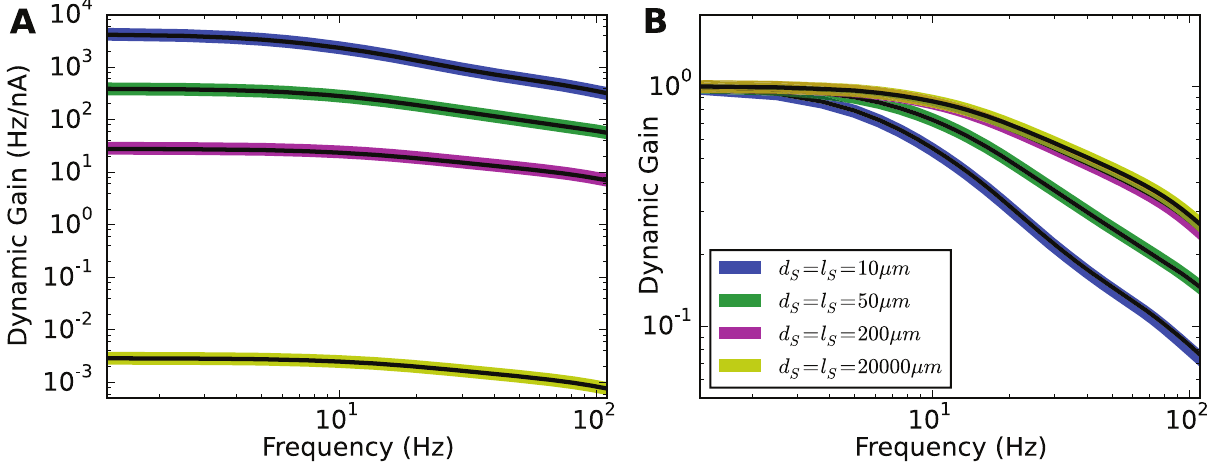
Fig 10. Effect of soma size on dynamic gain. A Unnormalized dynamic gain curves for various soma sizes. Diameters and lengths for all the soma are was fixed to 40 μ m. The correlation time τ was fixed to 5ms. For each soma size, fixing surface area but reducing shown in the legend panel in B . x Na soma length to 2 μ m, the dynamic gain curves were recalculated and represented as black lines, which overlapped with corresponding colored lines. B Comparison of all the normalized dynamic gain curves. Increasing the soma size enhances the dynamic gain in the high-frequency regime for Brette’s original